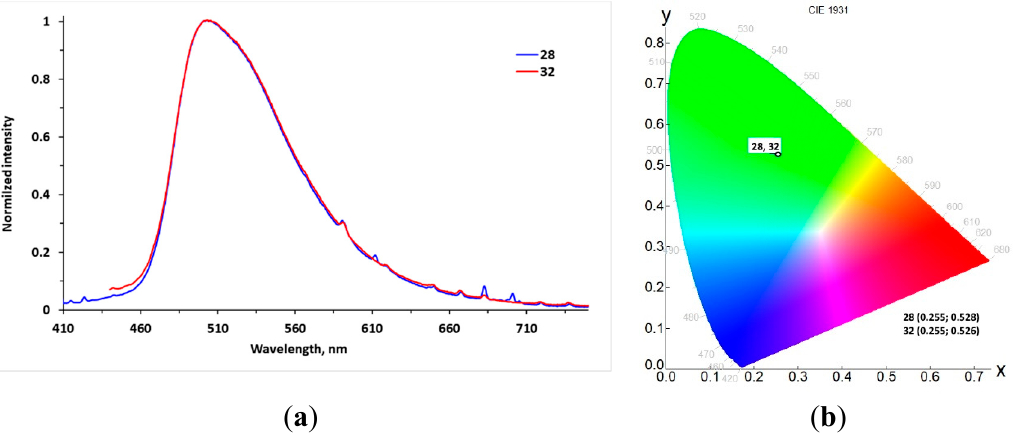
Figure 7. Emission (–) spectra ( a ) and CIE 1931 chromaticity diagram ( b ) for chromophores 28 and 32 in solid state.